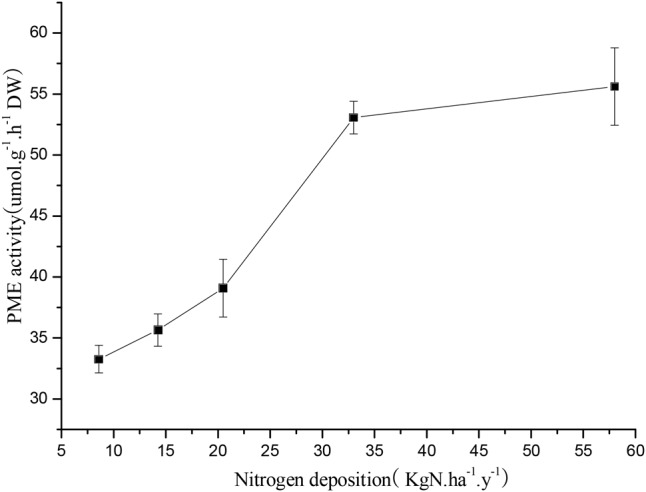
Response of phosphomonoesterase (PME) of R. calicaris var. japonica to nitrogen deposition (Mean ± SD, n = 3).